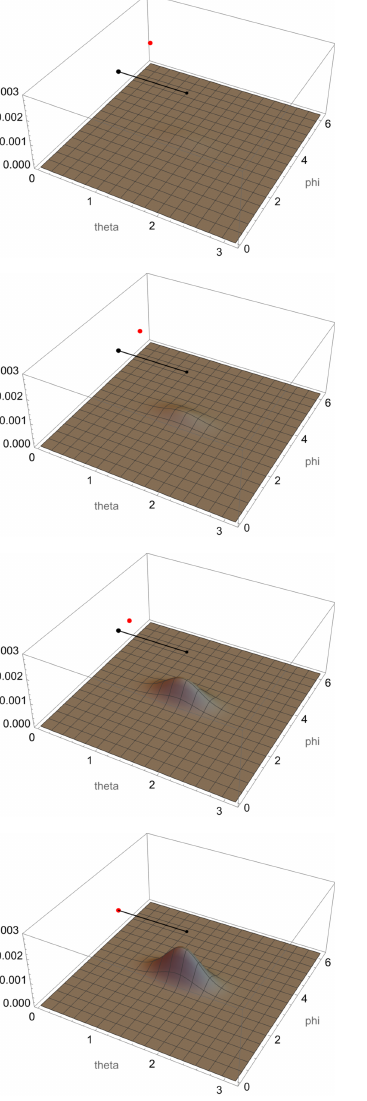
Figure 1 . Two sets of plots for a general off-diagonal symbol (3.46) for the N = 52 case. The two black connected dots denote endpoints of the string state The position of the red dot denotes the position of the label x 0 of the string state variables are all possible locations of the final end point y 0 on the sphere and the graph represents the value of K ( x, y ; x 0 , y 0 ) for the fixed x, y, x 0 and varying y 0 . The angular separation of the points in the first column of plots is a , in the second b , the sphere has unit radius. Since in this case L NC ≈ 0 . 2 , the first case is in the UV-regime, the second in the IR regime. We can clearly see that in the IR regime, the symbol is localized around the x = x 0 = y 0 , while in the UV regime the localization is around the x = x 0 , y = y 0